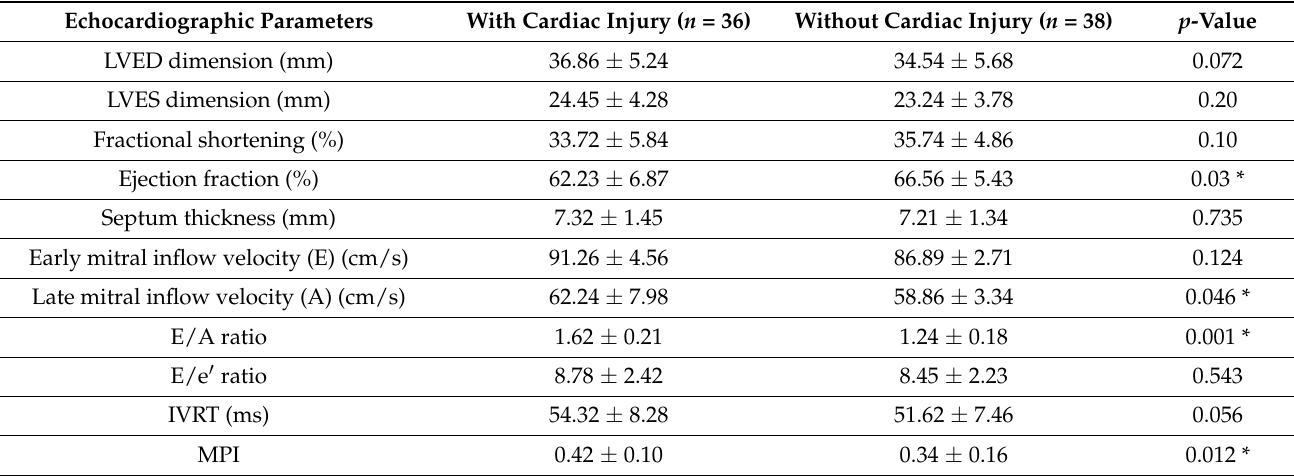
Table 2. Echocardiographic parameters in patients with and without cardiac